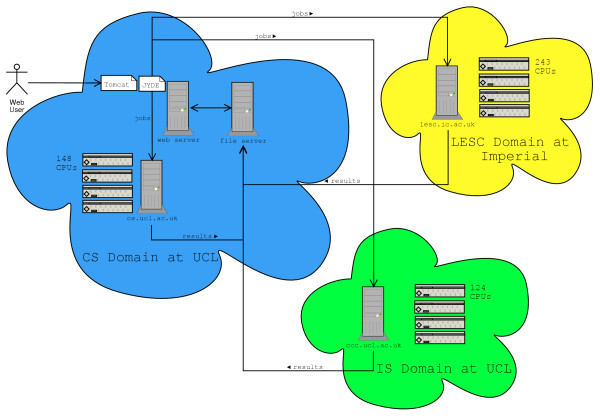
JYDE pipeline. Systems involved in the experiment and flow of data – see methods section for a detailed description.